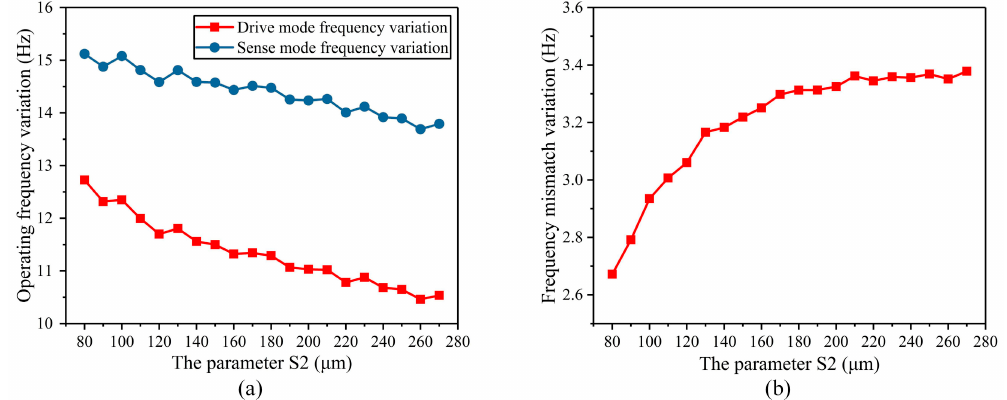
Figure 7. The parameter of the width of the stress-released structure (S 2 ) affected the variation of the operating frequency and frequency mismatch: ( a ) The degree of variation of the operating frequency; ( b ) the degree of variation of the frequency mismatch.